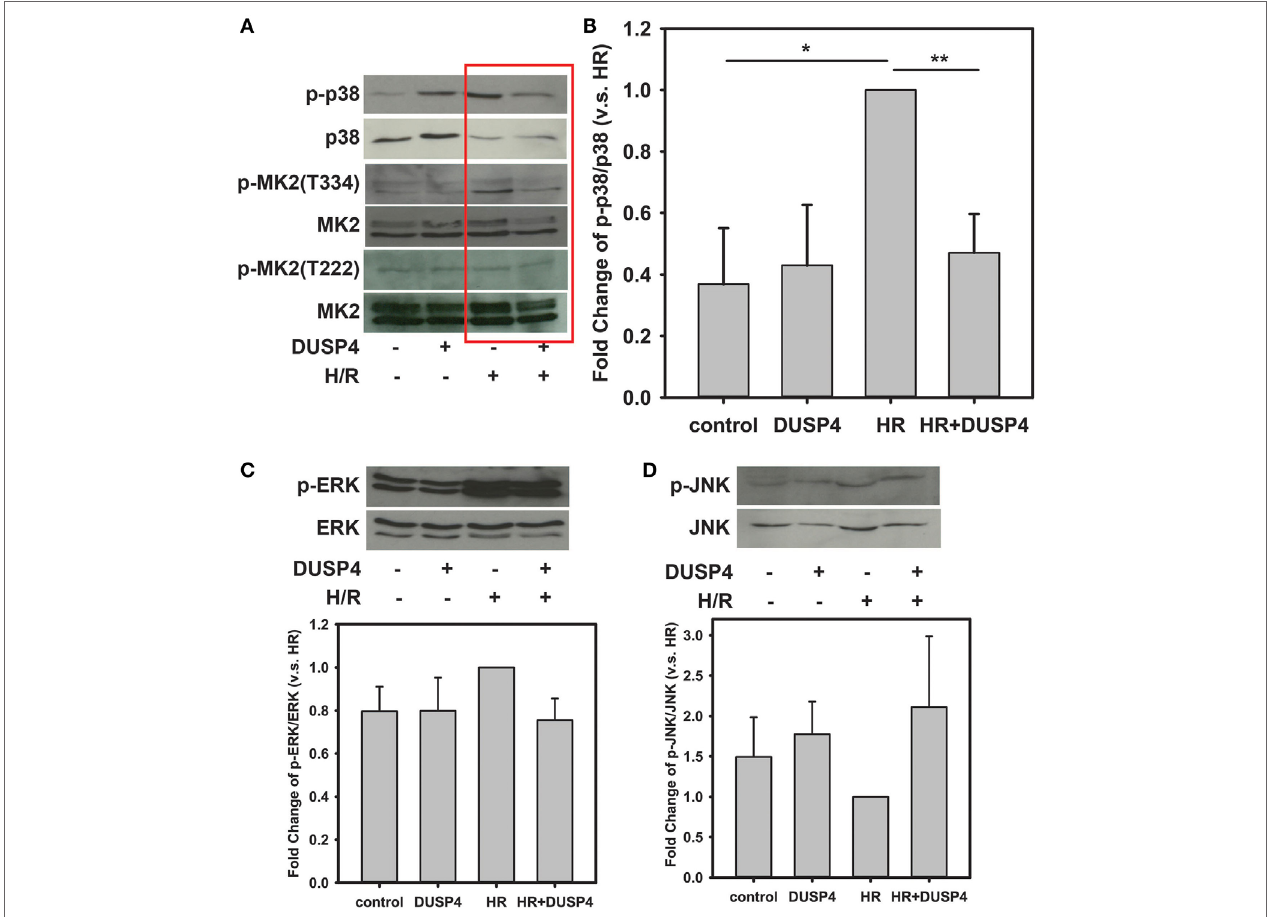
FigUre 2 | h/r-induced endothelial cell apoptosis is modulated by dual-specificity phosphatase 4 (DUsP4) and p38 activity . (a) Immunoblotting of bovine aortic endothelial cells after H/R. H/R treatment induces p38 activation. Phosphorylation of p38 subsequently activates its downstream target, MK2 increasing the phosphorylation at the T334 site, which can trigger caspase-3 activation and apoptosis. There was no effect on the phosphorylation MK2 at T222. Overexpression of DUSP4 prevents p38 overactivation and thus provides a beneficial effect for cell survival. (B) Statistic analysis of H/R-induced p38 activation. The ratio of p-p38/p38 is an indicator of the activity of p38. The ratio of p-p38/p38 of H/R treated group is set to 1. Overexpression of DUSP4 decreases p38 activity and prevents it from overactivation. * P < 0.01 and ** P < 0.005, n ≥ 3. (c) Under H/R, phosphorylation of ERK1/2 is increased; however, overexpression of DUSP4 does not reduce H/R-induced phosphorylation of ERK1/2. The ratio of p-ERK/ERK of H/R treated group is set to 1. (D) There is no effect on the phosphorylation of JNK either under H/R treatment or overexpression of DUSP4. The ratio of p-JNK/JNK of H/R treated group is set to 1. Data are expressed as mean ± SEM, n ≥